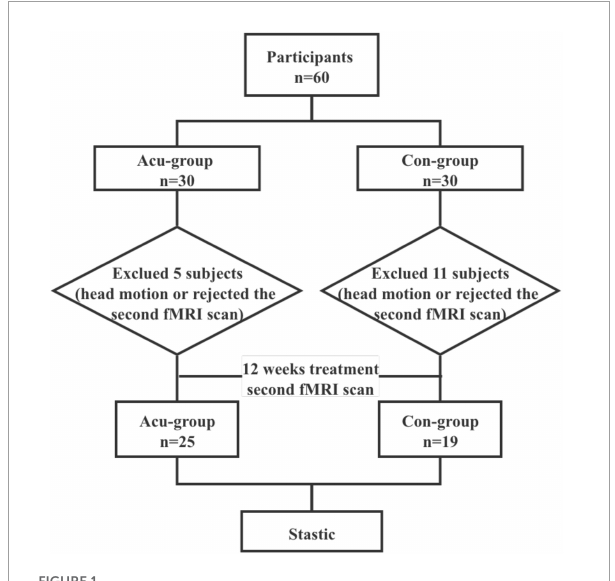
FIGURE1 Workflow and group inclusion/exclusion